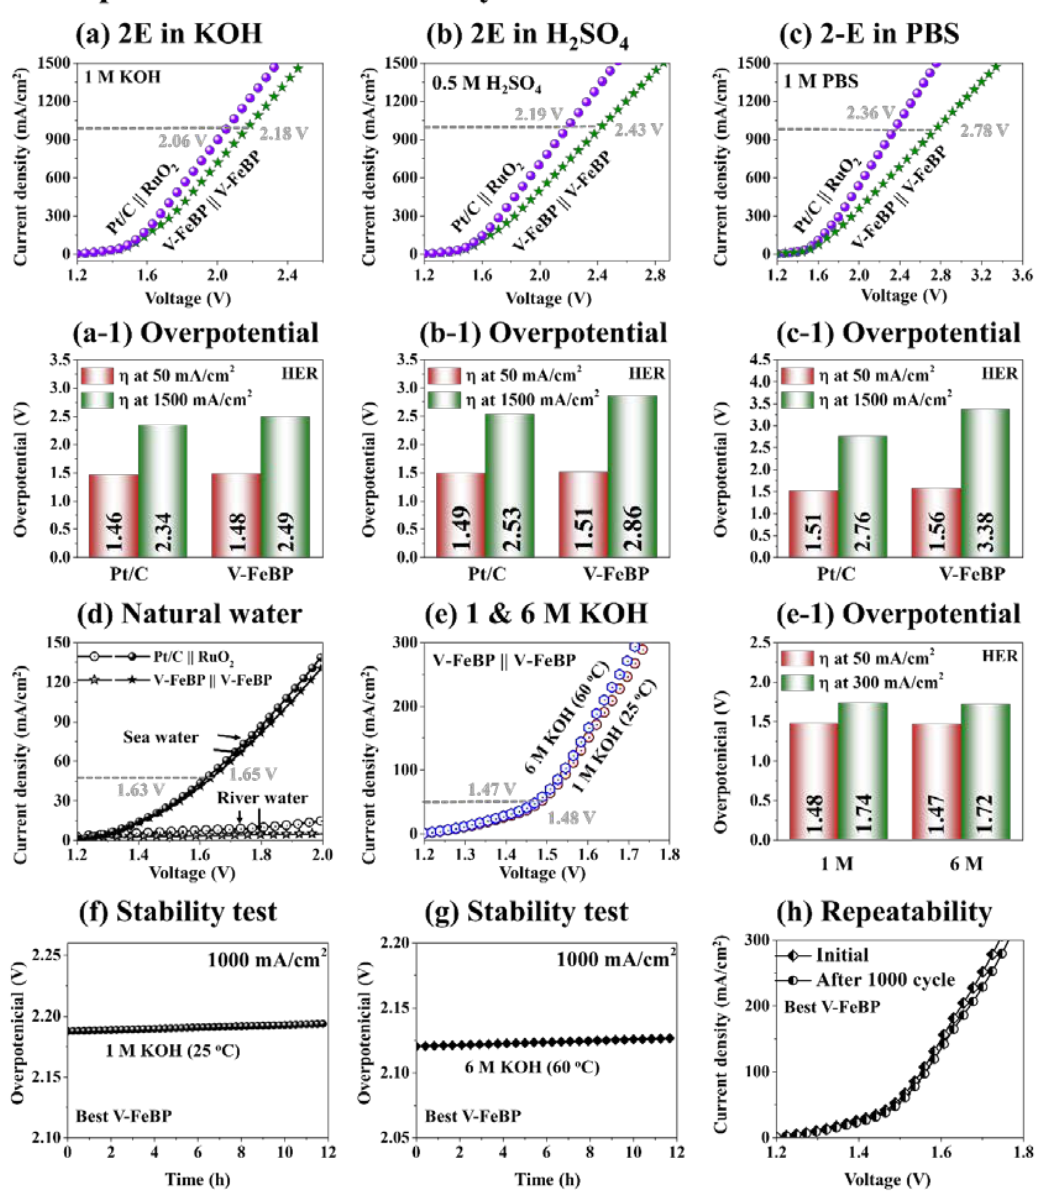
Figure 5. 2-E electrochemical performance in alkaline, acidic and neutral media and stability test. ( a – c ) 2-E LSV curves in 1 M KOH, 0.5 M H 2 SO 4 and 1 M PBS. ( a-1 – c-1 ) Overpotentials at 50 and 1500 mA/cm 2 . ( d ) 2-E LSV plots in natural sea and river waters. ( e ) 2-E LSV in 1 and 6 M KOH. ( e-1 ) Overpotentials at 50 and 300 mA/cm 2 . ( f , g ) Stability test of V-FeBP for 12 h in 1 M (25 ◦ C) and 6 M KOH (60 ◦ C) at 1000 mA/cm 2 . ( h ) 2-electrode repeatability test of V-FeBP before and after 1000 cycles in 1 M